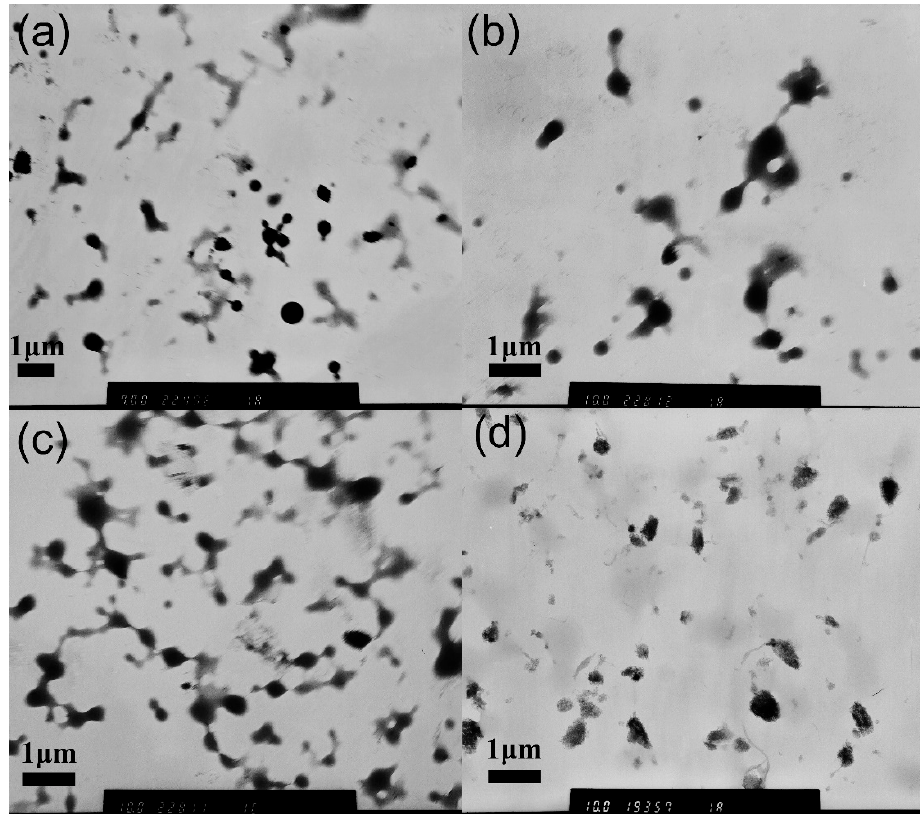
Figure 4. Transmission electron microscopy (TEM) images of mixing MPEG-PDLLA micelles with c-MWCNTs (addition at a mass ratio of c-MWCNTs/MPEG-PDLLA 0.1:1) for different times: ( a ) 0.5 h; ( b ) 2 h; ( c ) 6 h; ( d ) 24